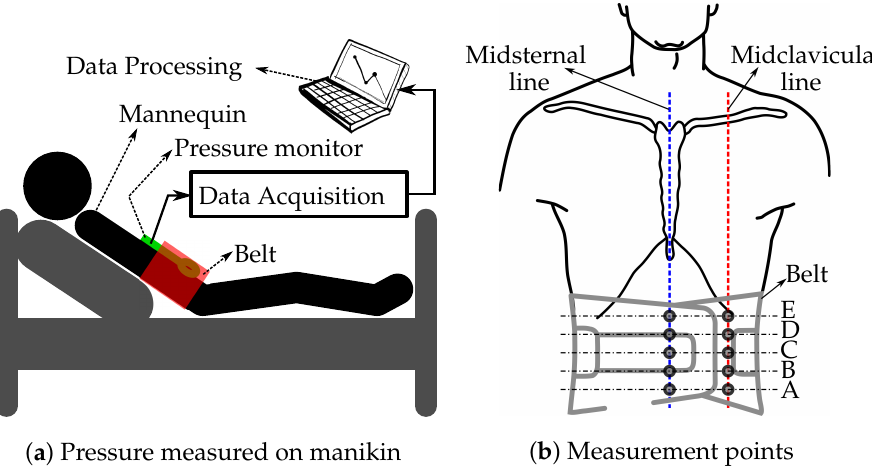
Figure 1. Illustration of the belt and pressure monitor placed on the manikin ( a ) and the loca- tions where the pressure values under the inflated belt are measured along the midsternal and left midclavicular lines ( b